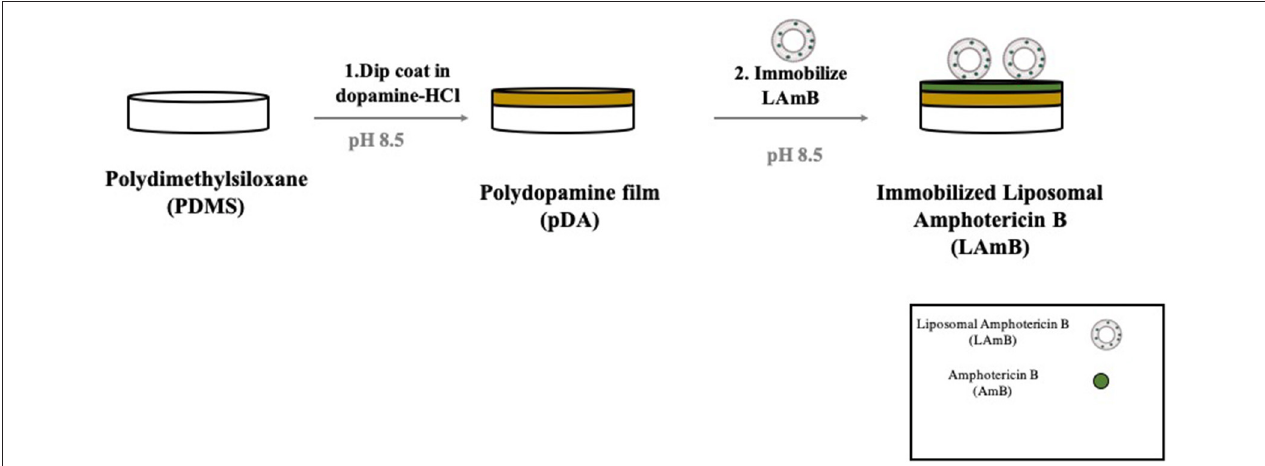
FIGURE 1 | Schematic representation of polydopamine (pDA) coating developed for liposomal Amphotericin B (LAmB) immobilization on polydimethylsiloxane (PDMS). Materials were first functionalized with a layer of pDA, followed by LAmB immobilization adapted from Xu et al. (2017).